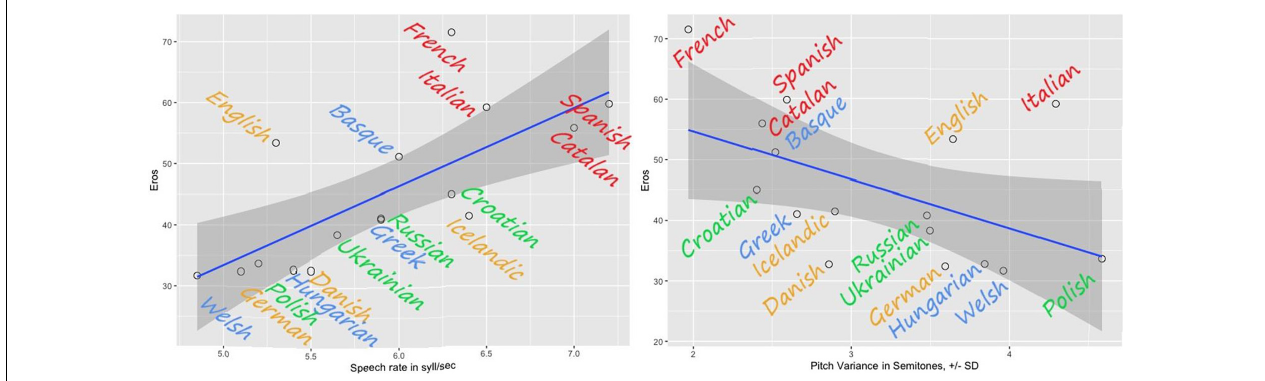
FIGURE 8 | The relationships between the Eros factor and the speech rate (on the left ) and the Eros factor and the pitch variance (on the right ). The highest Eros ratings are assigned to faster flatter